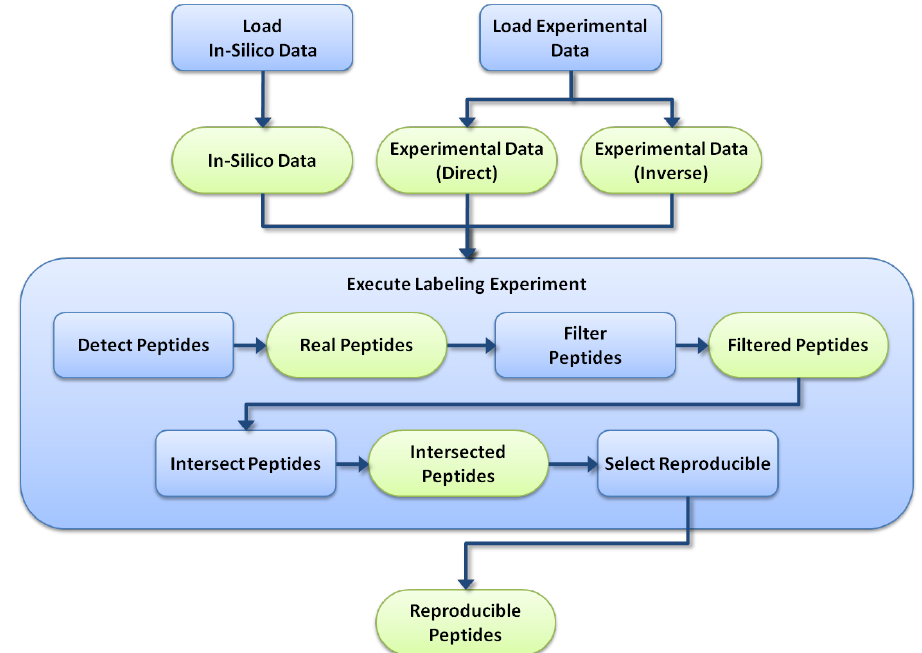
Figure 5: DPD labeling experiment workflow.